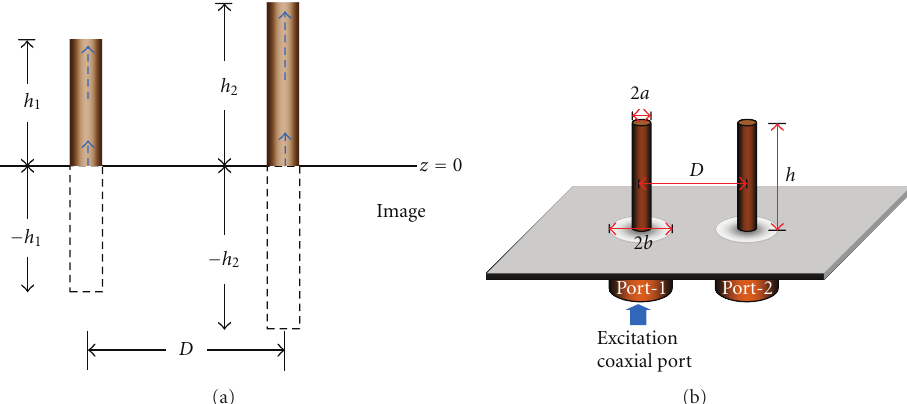
Figure 8: (a) Arbitrary lengths of two parallel, mutually coupled monopoles; (b) actual configuration of coupling monopole with one excitation port.